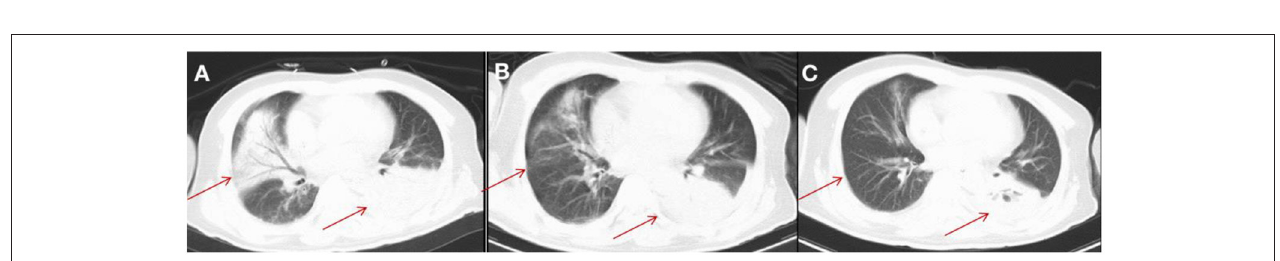
FIGURE 2 | CT imaging for the patient’s brain. (A) On day 25, a CT scan of the brain showed hyperdense lesions with surrounding edema in the right parietal lobe (red arrow) and hypodense areas (blue arrow) in the left and right parietal lobes. (B,C) After 2 and 3 weeks of treatment, a CT scan showed that the lesions were absorbed in the left and right brain (red arrow and blue arrow).